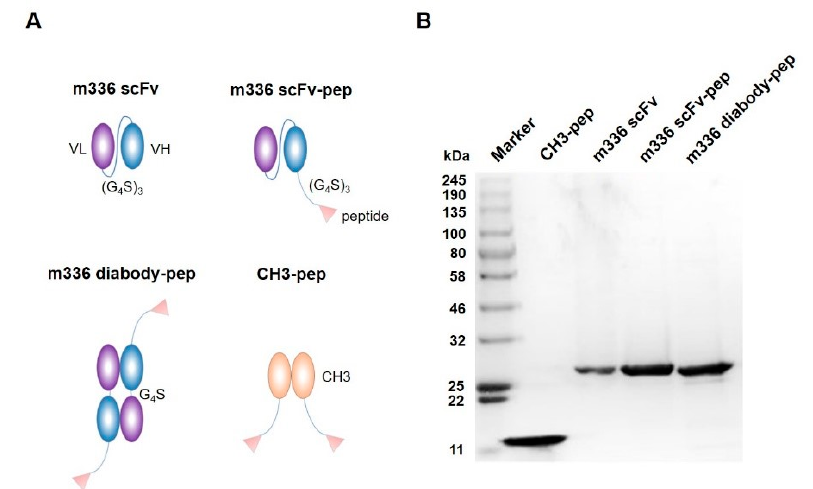
Figure 1. Construction and characterization of anti-MERS-CoV inhibitors. ( A ) Schematic structure of proteins m336 scFv, m336 scFv-pep, m336 diabody-pep, and CH3-pep. ( B ) SDS-PAGE of the anti-MERS-CoV inhibitors.